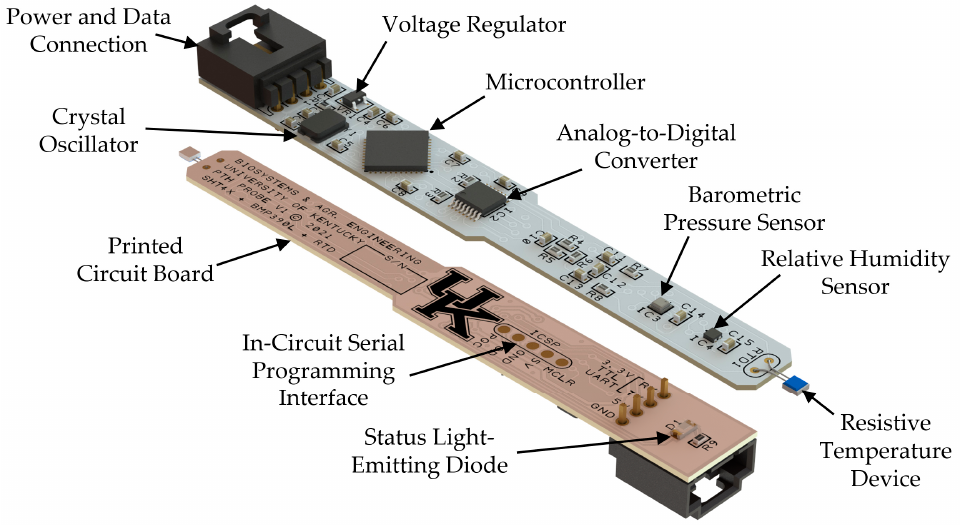
Figure 1. Top and bottom isometric views of the PTH probe design with main components identi-